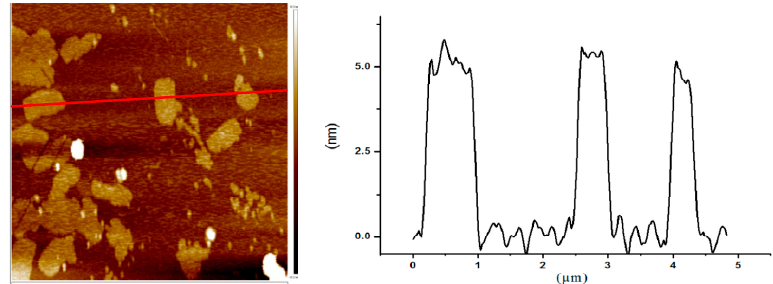
Figure 2. AFM image of the GO nanosheets and depth profile of the line on the GO nanosheets.